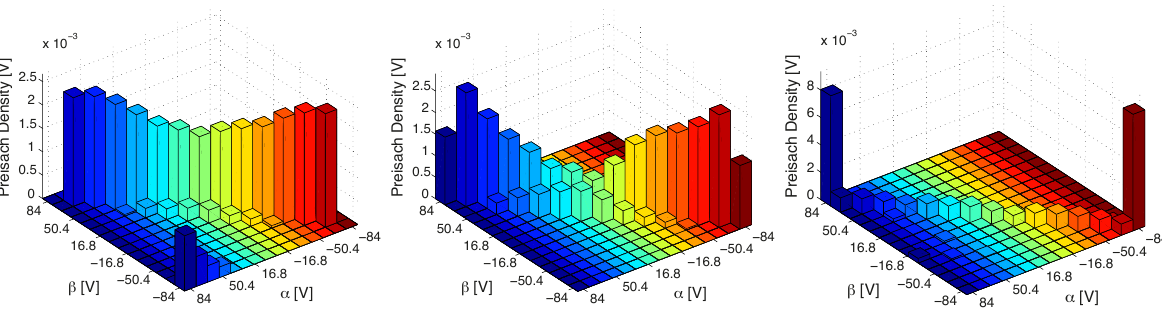
Figure 7: Showing the detrimental effects on the Prisach weight function using wrong input amplitudes for identification of the discrete model. The model is defined for an input range of